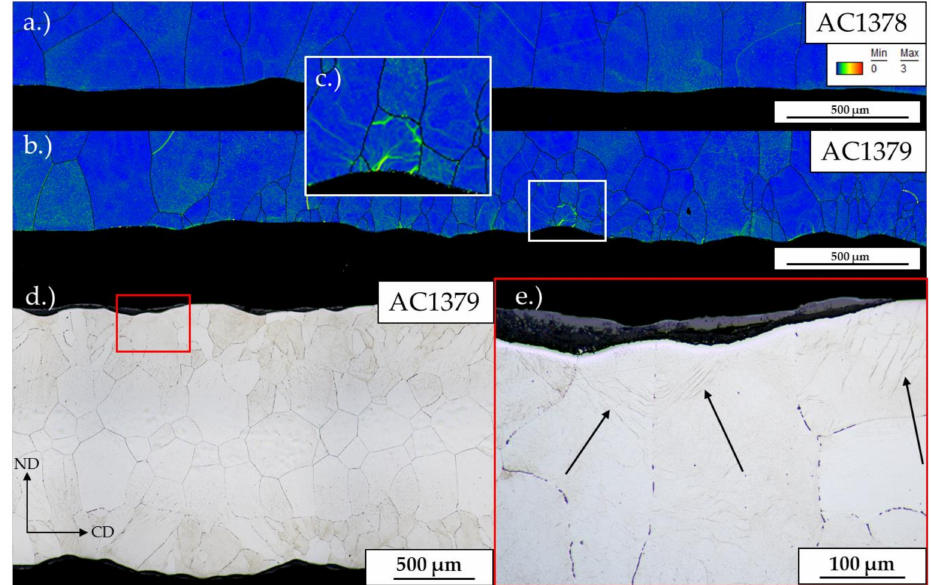
Figure 3. KAM-maps of the surface areas from ( a ) AC1378 and ( b ) AC1379. ( c ) shows a magnified section of ( b ). Microstructure of water-cooled AC1379 cast sample obtained by LOM is represented in ( d ) and with enlarged detail in ( e ). (image source for ( a – c ): GfE RWTH